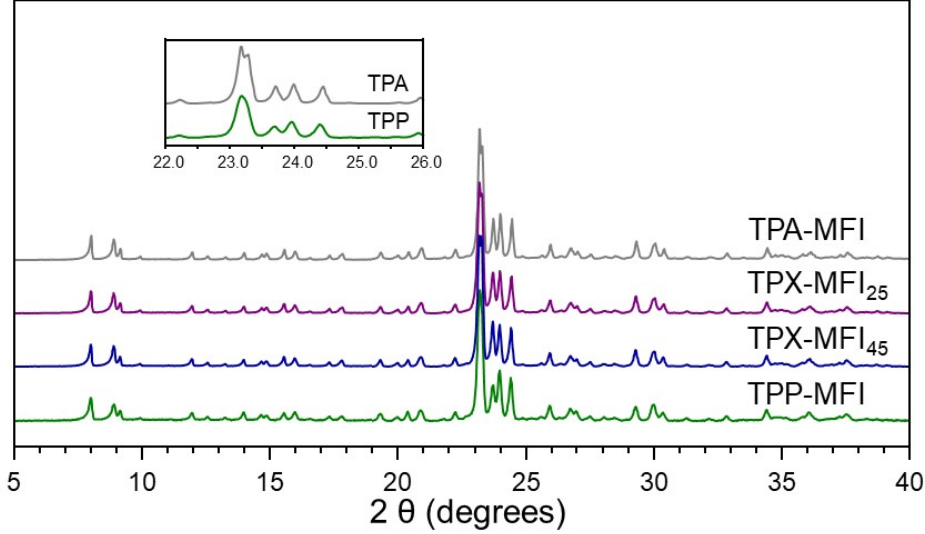
Figure 2. XRD patterns of silicalite-1 samples synthesized using TPA, TPP, and mixtures of them as OSDAs. The inset corresponds to the magnification of the range between 22–26 ◦ . OSDAs. The inset corresponds to the magnification of the range between 22–26°.